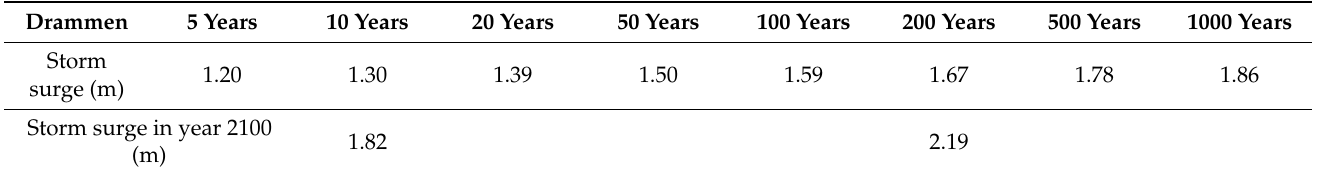
Table 3. Overview of storm surge values in Drammen taken from NVE’s report